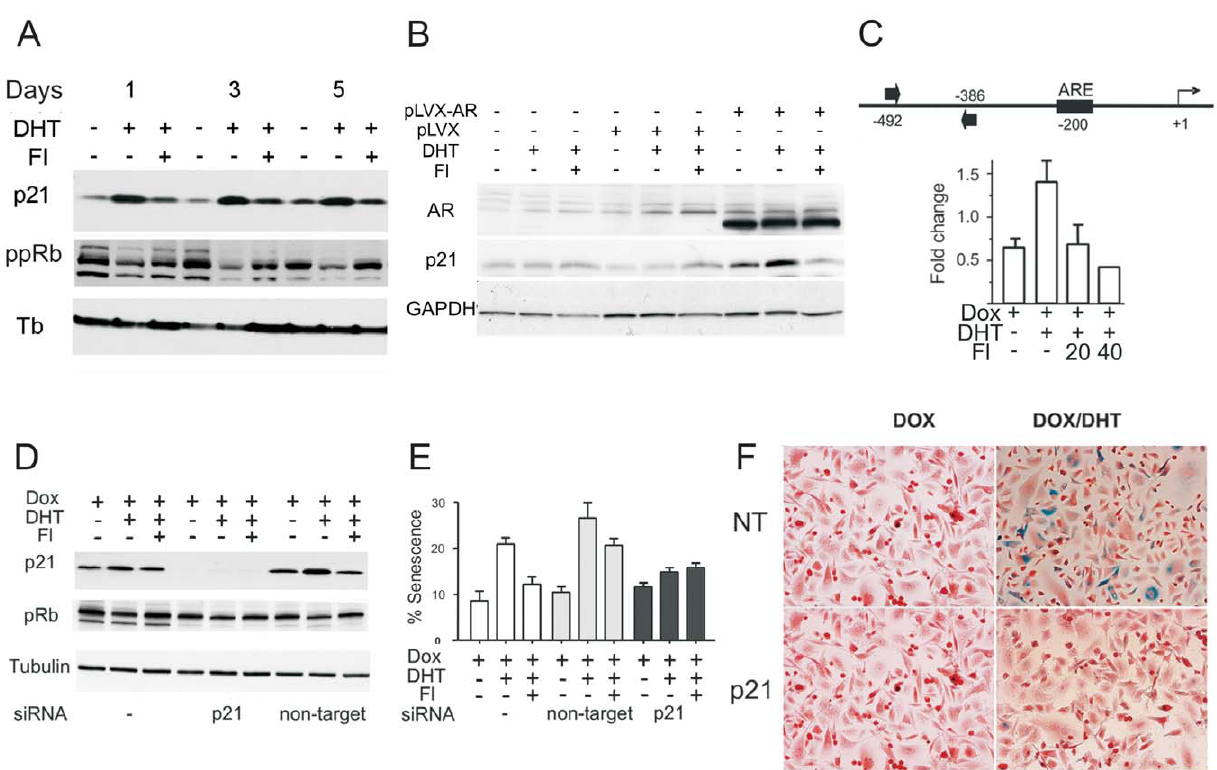
Figure 3. p21 is regulated by AR and required for cellular senescence. AR-dependent senescence required increased p21. ( A ) PC3-AR cells were treated with Dox, DHT and Fl, at indicated combinations; cell extracts were analyzed by Western blot for p21, and ppRb. Tubulin was used as a loading control (A). Note the decrease in Rb phosphorylation and p21 increase in DHT-treated cells at every time point. ( B ) RWPE-1 cells, non- transfected or transfected with pLVX-AR or pLVX vector were treated with vehicle EtOH and DHT with or without Fl. Cell extracts were analyzed for AR, p21 and GAPDH to assess loading. ( C ) AR binding to p21 promoter: ChIP was performed with AR antibodies and AR-bound DNA amplified with the primers for the promoter region adjacent to the putative ARE element within p21 promoter (top) using real-time PCR. Each sample was run